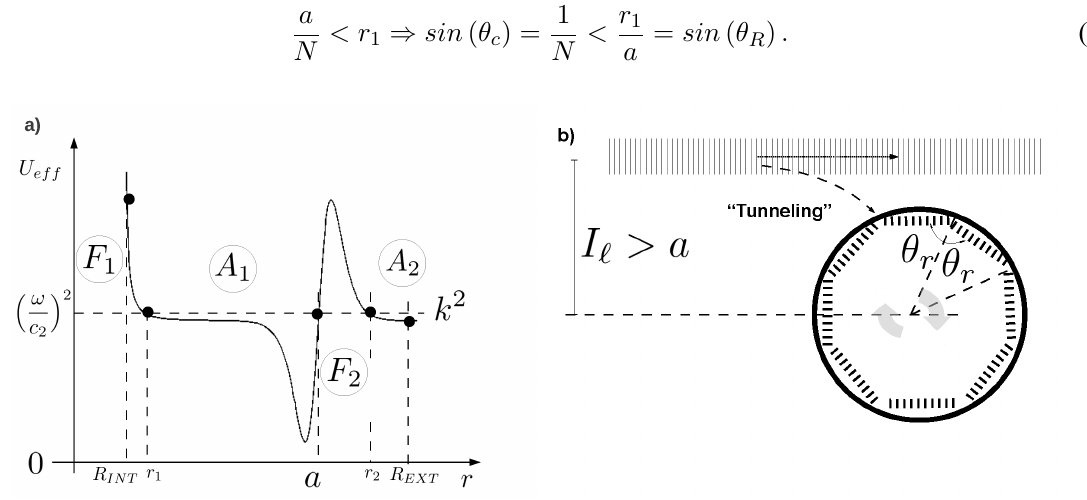
Figure 5 - In ( a ), for a given incident “particle” with positive energy k 2 ( k ≡ ω / c 2 ) is shown the “Energy budget” mechanism associated with the “excitation” of resonant “Quasi-Bound States”(QBS). Notice that r 2 = I (cid:96) = ( (cid:96) + 1/2)/ k and r 1 = I (cid:96) / N . In ( a ), the classically allowed regions A 1 and A 2 correspond to propagating waves, whereas the classically forbidden regions F 1 and F 2 are related to the evanescent waves. Figure ( b ) shows the equivalent ray-trajectory picture related to these